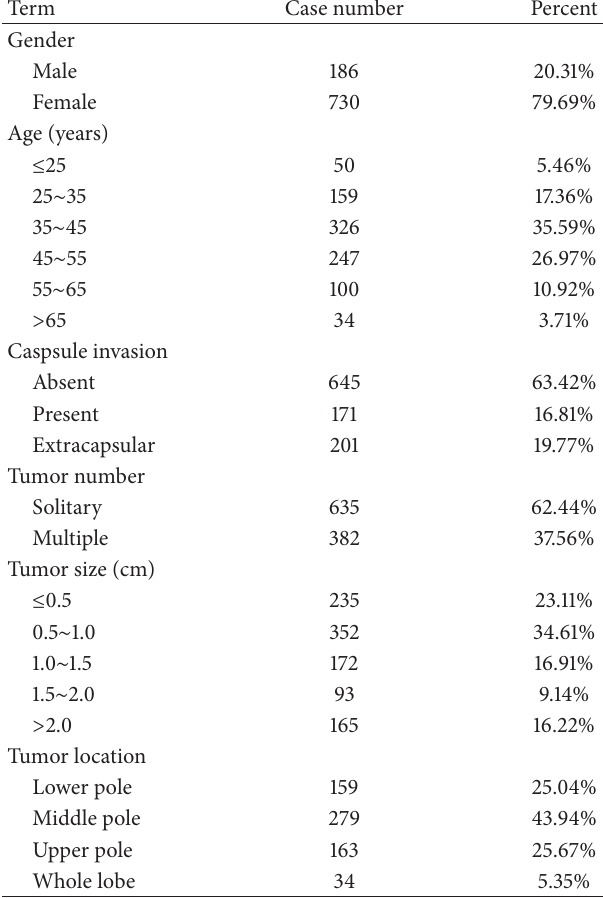
Table 1: Patient demographics and clinical